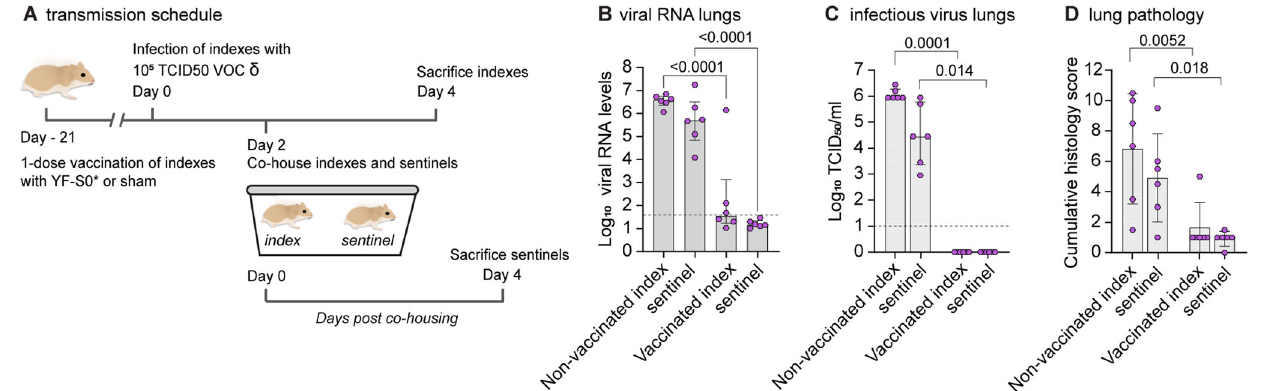
Fig. 5 | A vaccine based on updated spike antigen S* prevents transmission of VOC Delta. Effect of YF-S0* vaccination on viral transmission to non-vaccinated contact hamsters ( n =6 per group). Index hamsters were either sham vaccinated ( n =6) or vaccinated ( n =6) with a single dose of 10 4 PFU of YF-S0* and infected intranasally on day 21 with 10 5 TCID 50 of VOC Delta. Two days after infection, index animalswerepairedandco-housedwitheachonenaïvesentinelfor2days.Indexand sentinel animals were sacri fi ced each 4 days after infection or start of exposure,